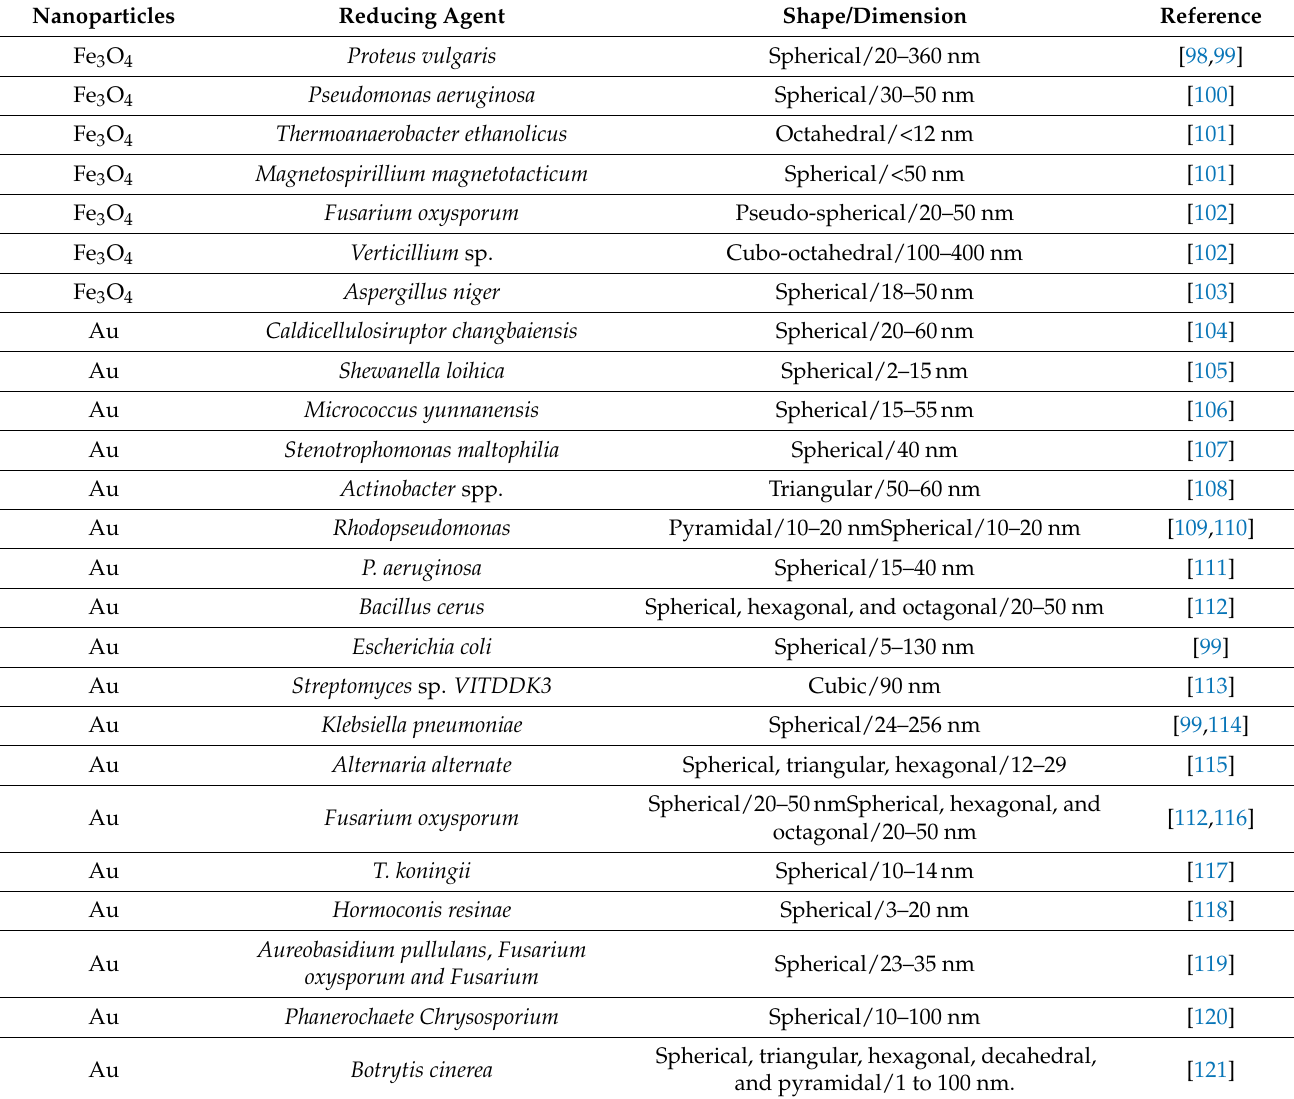
Table 1. Fe 3 O 4 and Au nanoparticles recently produced using